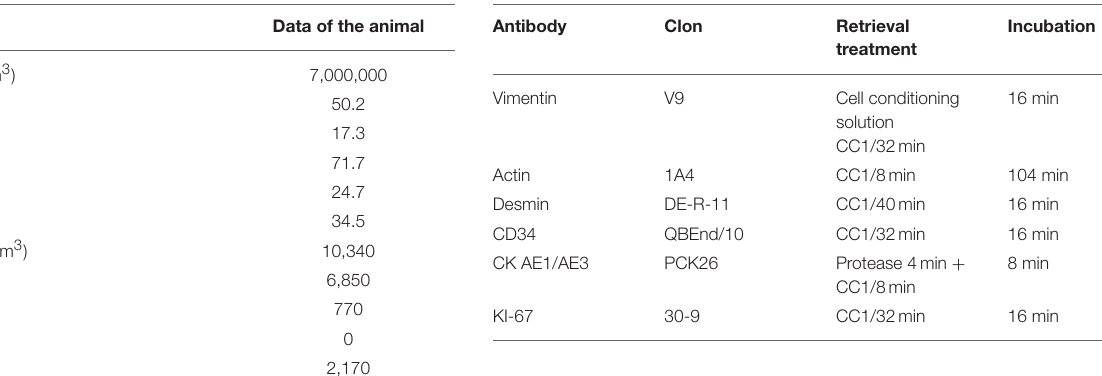
TABLE 3 | Details of primary